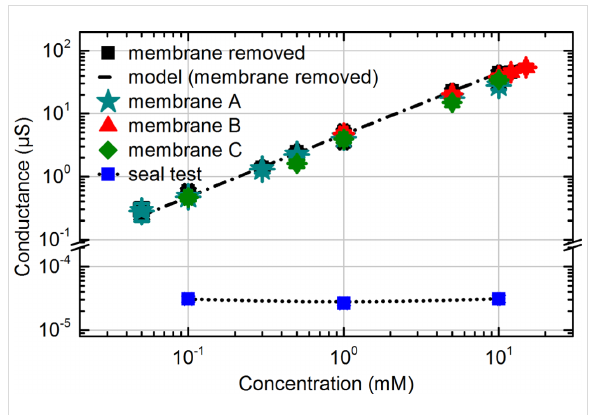
pores (membrane C). For comparison, the corresponding diame- ter distribution of the Au NPs used as etch mask is added. The fitted distributions were derived from datasets consisting of